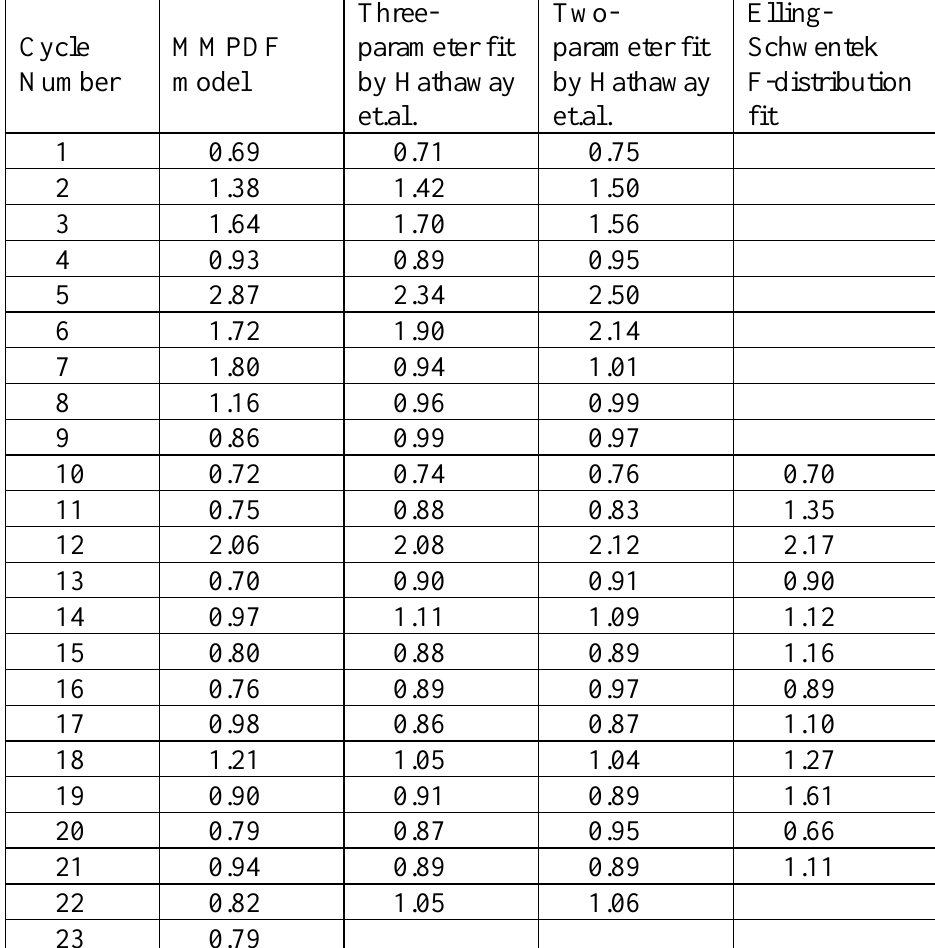
Table 2: Hathaway, Wilson and Reichmann χ -measure of the goodness of fit value computed for all the 22 sunspot cycles with different models. MMPDF shows good fit compared with other